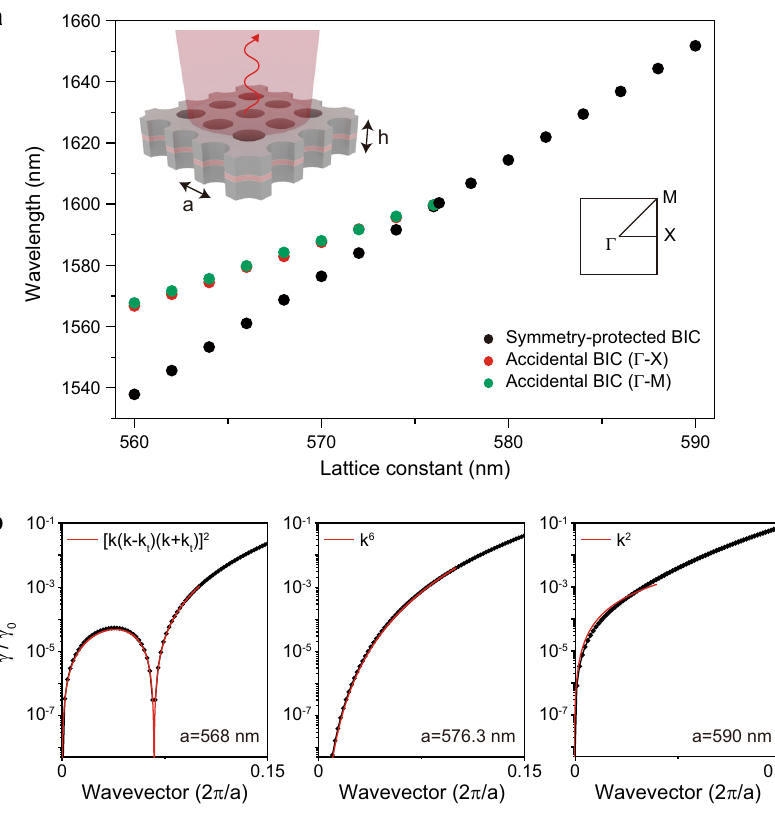
Fig. 1 Merging of BICs in the in fi nite-size structure. a Calculated wavelengths of the symmetry-protected BIC (black dots) and the two accidental BICs (red and green dots) as a function of the lattice constant. The merging of the BICs occurs at a = 576.3 nm. The inset shows the schematic of the laser structure: the lattice constant is a and the slab thickness is h . b Calculated radiation loss ( γ ) normalized by the value near the light cone ( γ 0 ), γ / γ 0 , along the Γ X-direction wavevector. Three lattice constants are examined (from left to right): a = 568 nm (before merging), 576.3 nm (at merging), and 590 nm (isolated). The calculated curves (black dots) are fi tted by [ k ( k – k t ) ( k + k t )] 2 , k 6 , and k 2 (red curves), at a = 568, 576.3, and 590 nm,